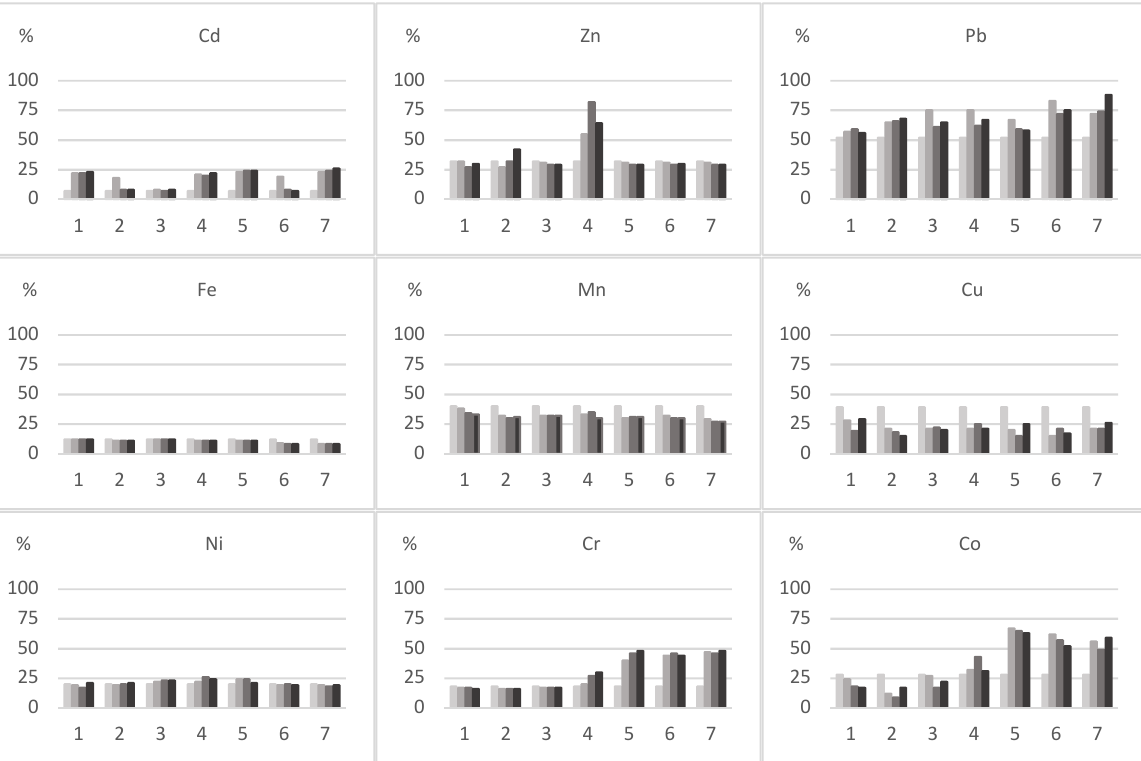
Figure 1. Availability factor (AF %). control (0); first metal dose (I); second metal dose (II); third metal dose (III).